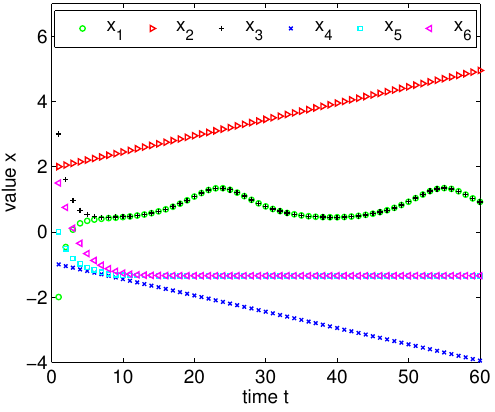
Figure 5. Time evolution of the agents’ values, where v 2 and v 4 are faulty nodes following x 2 ( t + 1 ) = 2 + t /20 and x 4 ( t + 1 ) = − 1 − t